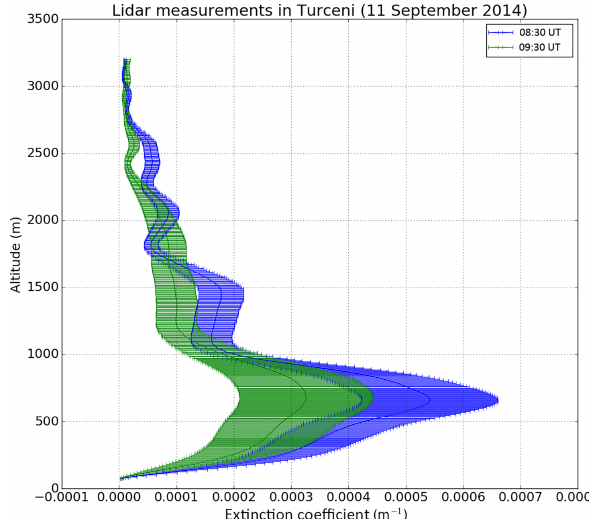
Figure 5. Lidar measurements in Turceni on 11 September 2014, at 08:30 and